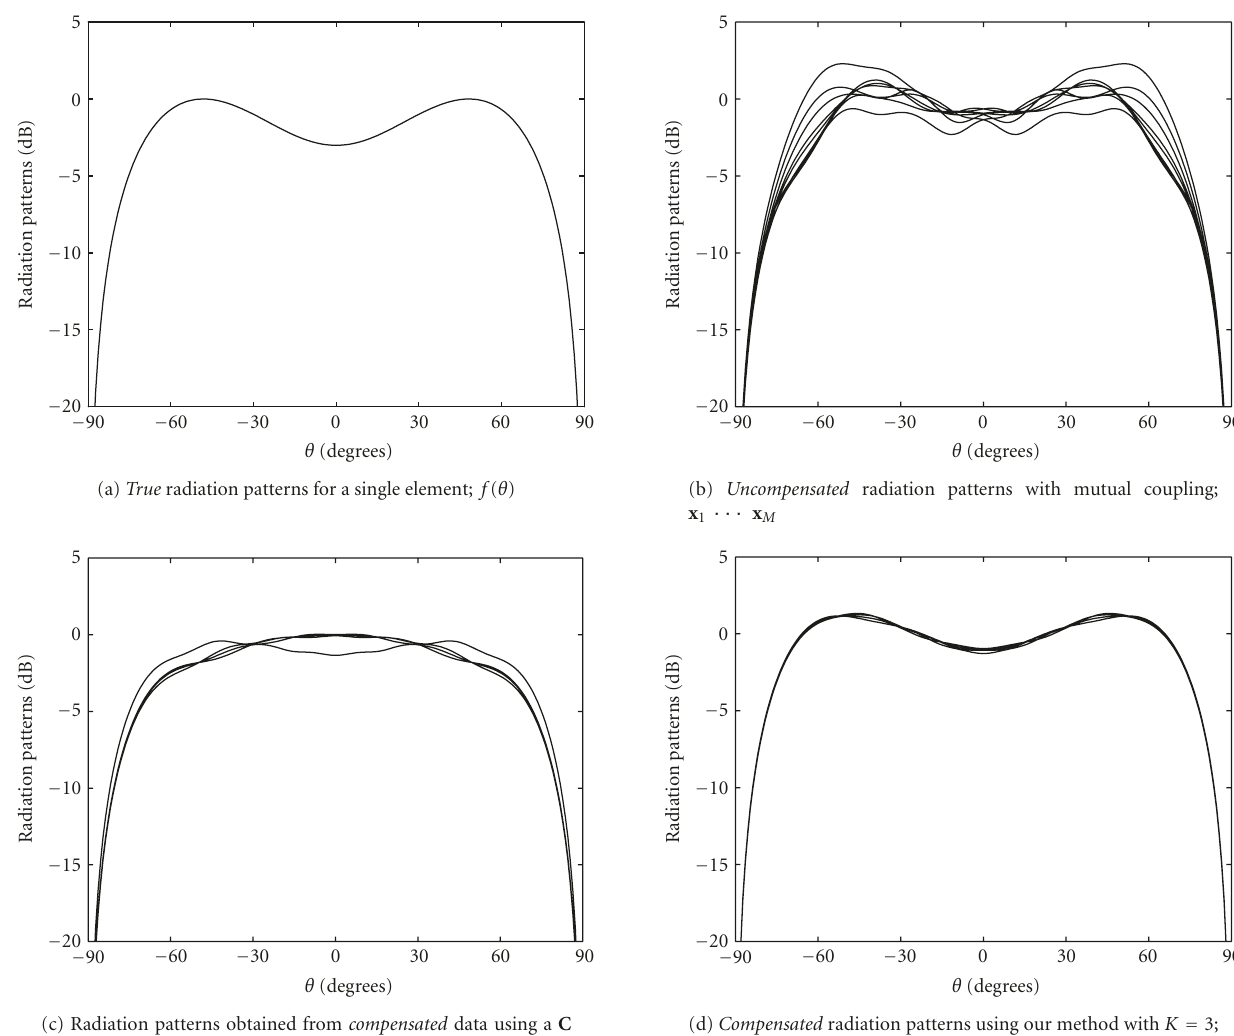
Figure 3: Compensation for mutual coupling for an array of 8 dipoles placed h gp = 3 λ/ 8 over a ground